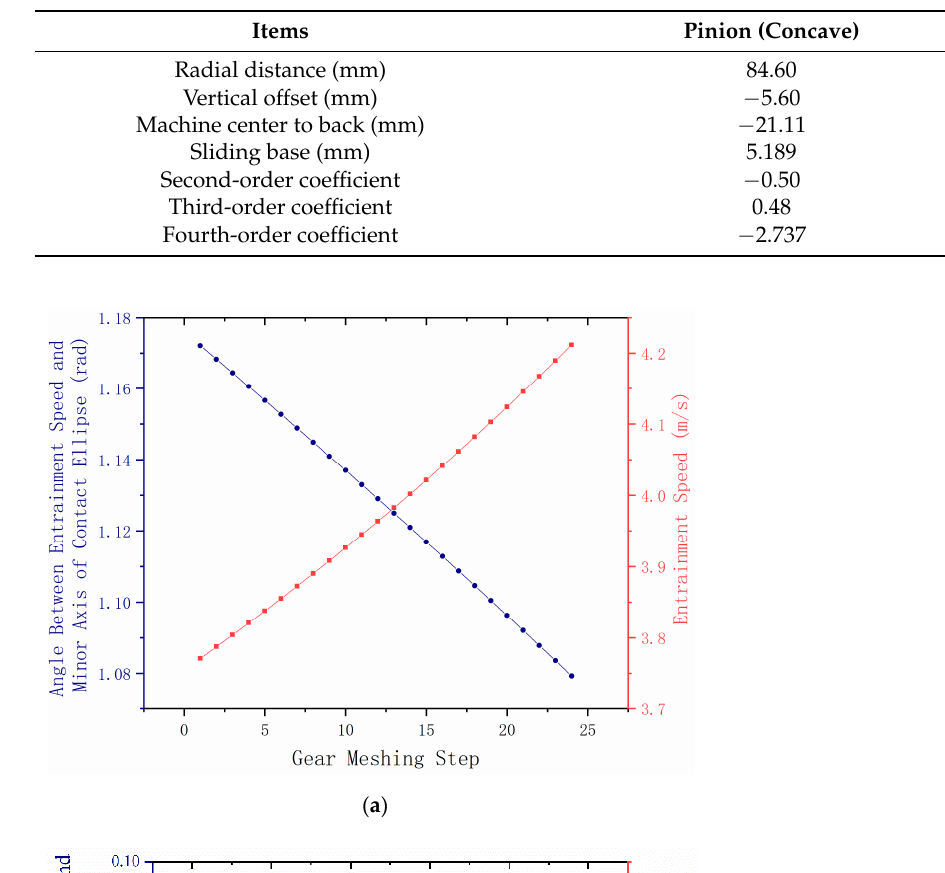
Table 3. Optimal machining parameters based on machining parameter optimization.